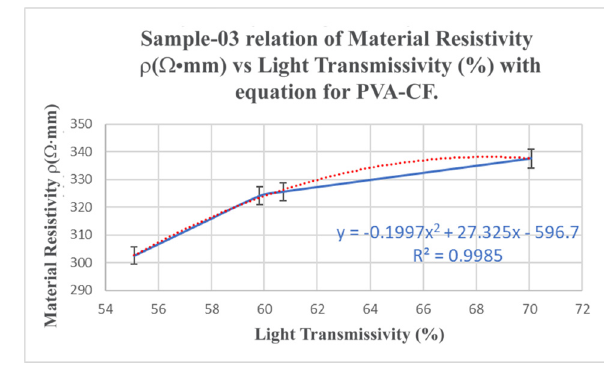
Figure 25: Sample - 05 ( CF:PVA = 1.0:30 ) light transmittance ( % ) versus block resistance ( Ω ) with equation for PVA - CF. The dotted lines represent the polynomial fi tted curve and the linear fi tted line.